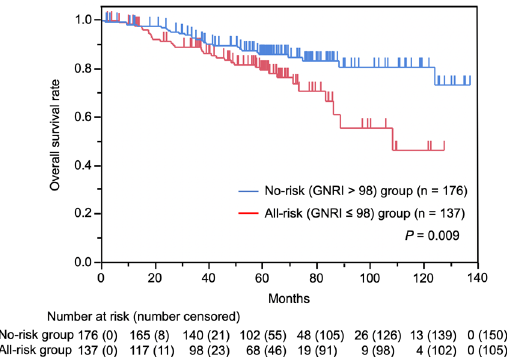
Figure 3. Kaplan-Meier analysis of overall survival according to GNRI. Overall survival rate is significantly worse in the all-risk GNRI ( ≤ 98) group than in the no-risk GNRI ( > 98) group ( P = 0.009).